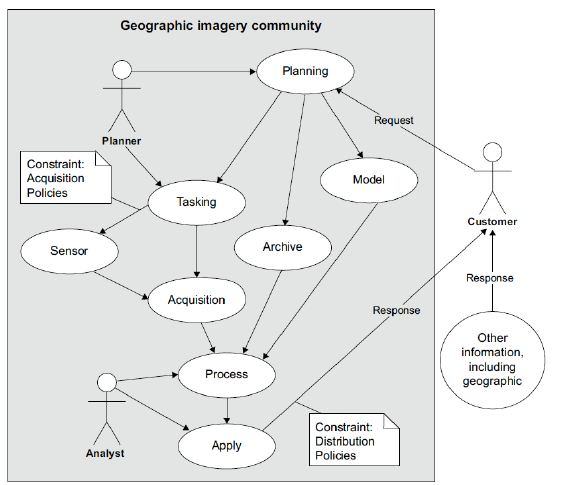
Figure 2. Geospatial Imagery Observation Request